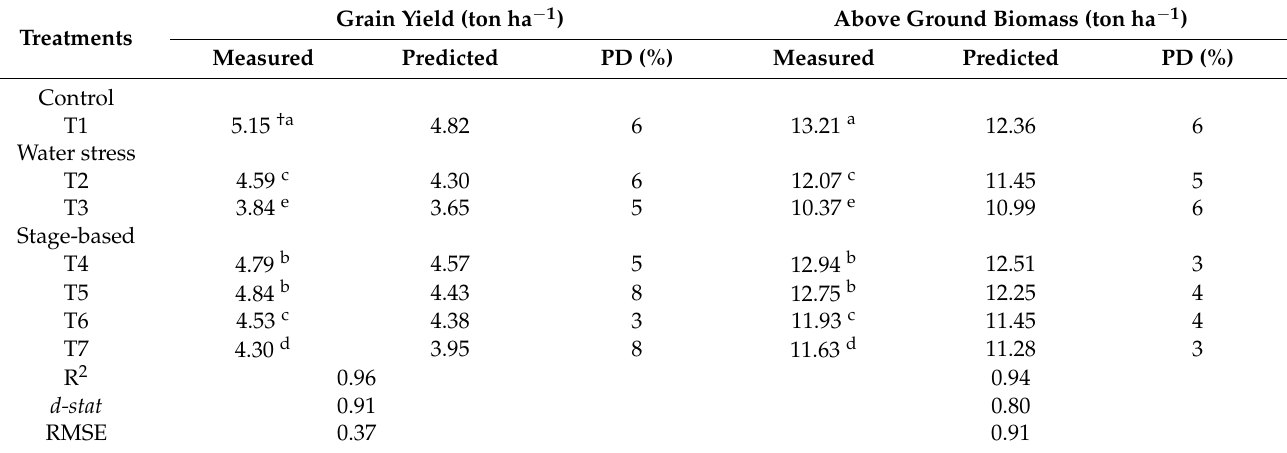
† Mean values within the same column for each trait with the same lower-case letter are not significantly different according to Tukey’s HSD (honestly significant difference) test at p ≤ 0.05. T1, 100% ETc throughout the growing season; T2, 75% ETc throughout the growing season; T3, 50% ETc throughout the growing season; T4, 50% ETc at tillering stage only + 100% ETc in the rest of stages; T5, 50% ETc at booting only + 100% ETc in the rest of stages; T6, 50% ETc at grain filling stage only + 100% ETc in the rest of stages; and T7, 50% ETc at tillering and grain filling stages only + 100% ETc in the rest of